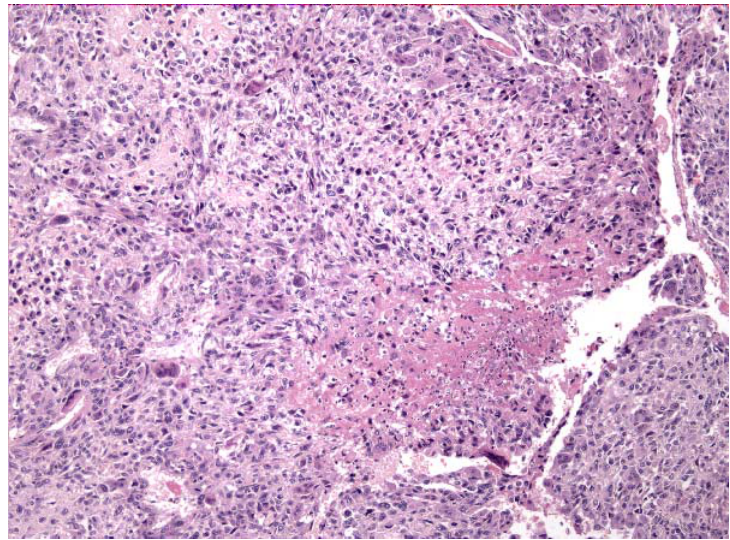
FIGURE 3. Photomicrograph H&E ( × 100 original magnification) showing extensive necrosis.